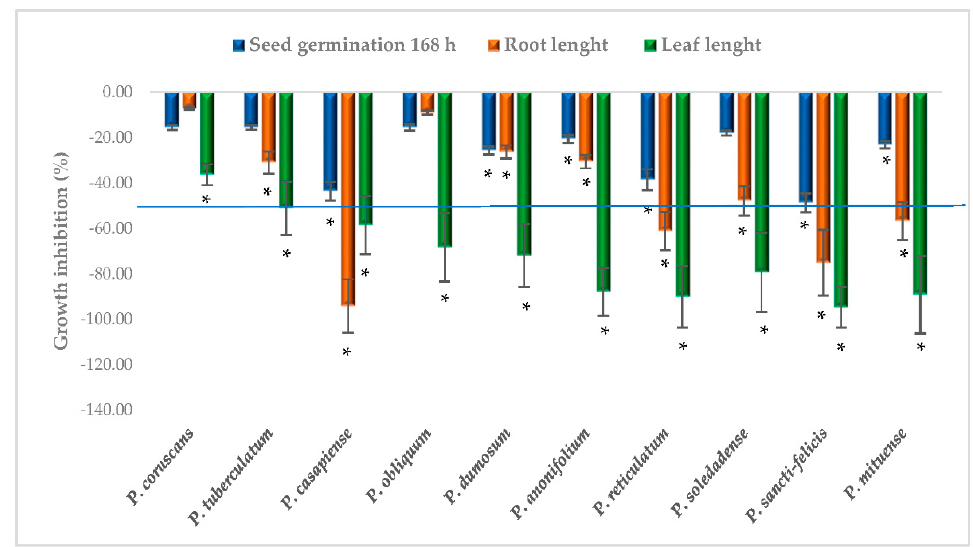
Figure 3. Phytotoxic effects (% inhibition) of the Piper EOs on Lolium perenne, seed germination, and root and leaf growth. Bars represent the average relative values ± standard error ( n = 25 plants measured). * Significantly different from the control ( p < 0.05), Fisher’s least significant differences test (LSD).